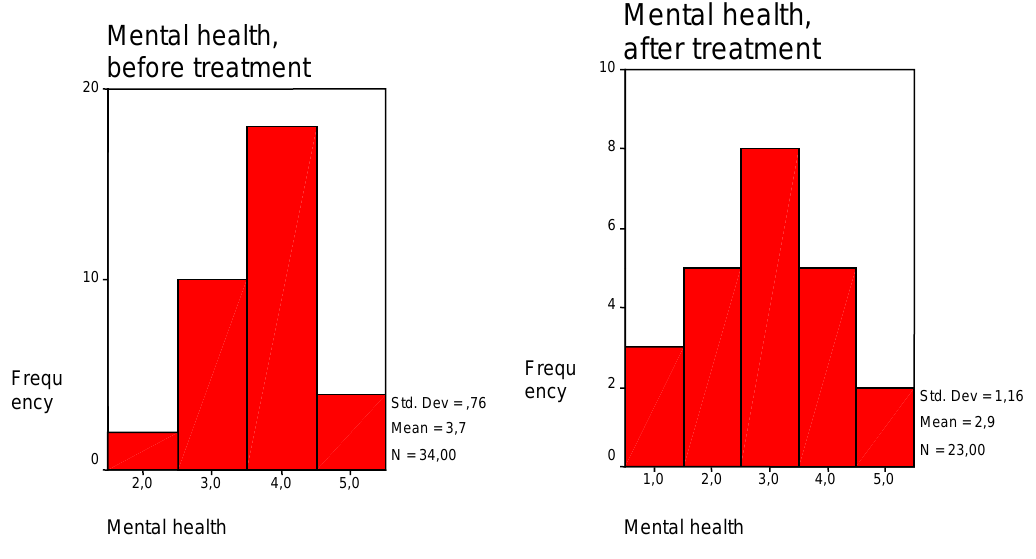
FIGURES 26 and 27 . Holistic healing of 34 patients with a long history of mental problems. Most of the patients were rating their own mental health as “bad” before treatment; after treatment, most of the patients rated their mental health as “neither good nor bad”. The improvement was from a mean of 3.7 to a mean of 2.9.